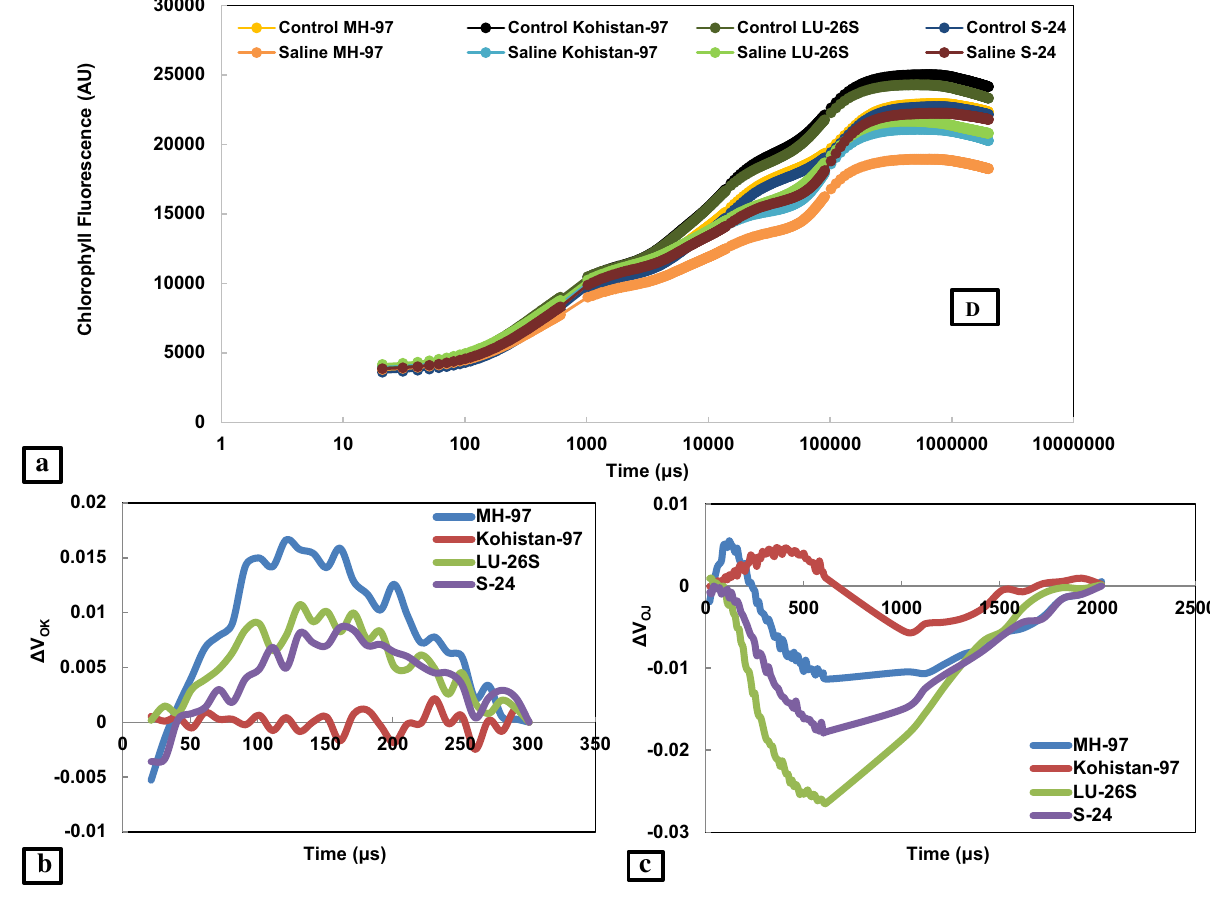
Figure 4. Kinetic differences of four selected wheat cultivars subjected to 0 or 150 mM NaCl stress ( a ) Raw OJIP chlorophyll a fluorescence transients ( b ) Double normalized between Fo and Fk (L-band) ( c ) Double normalized between Fo and Fj